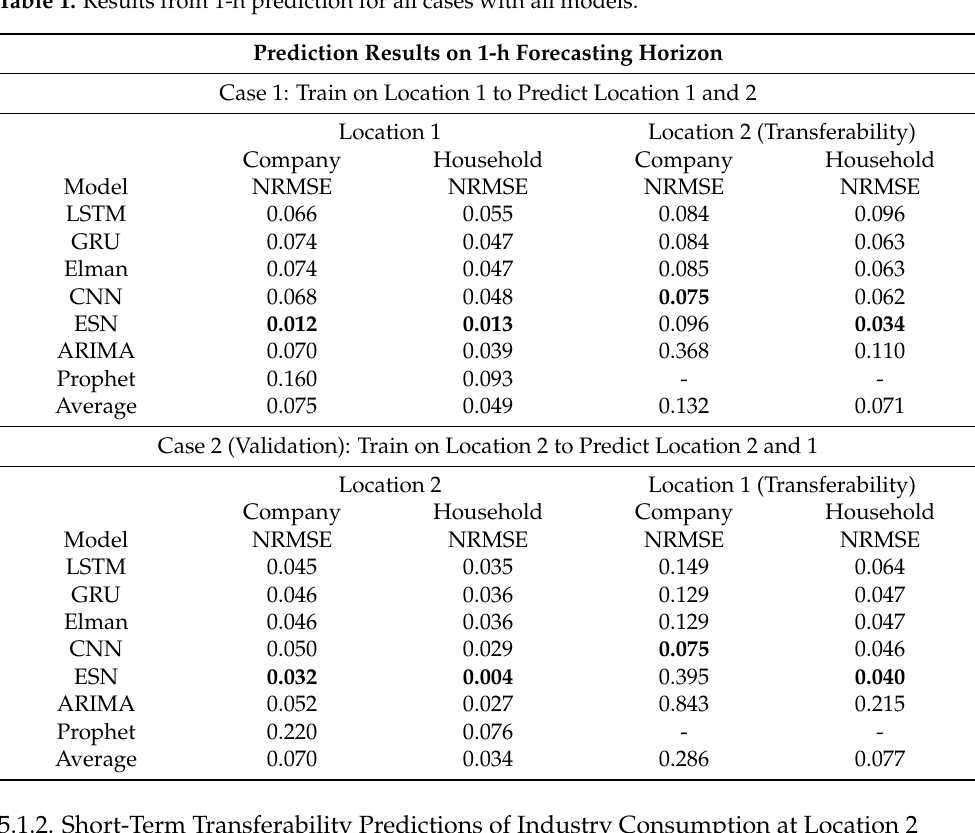
Table 1. Results from 1-h prediction for all cases with all